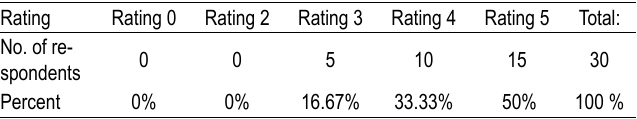
X = 3.27 Table 5. condition of patients after therapy